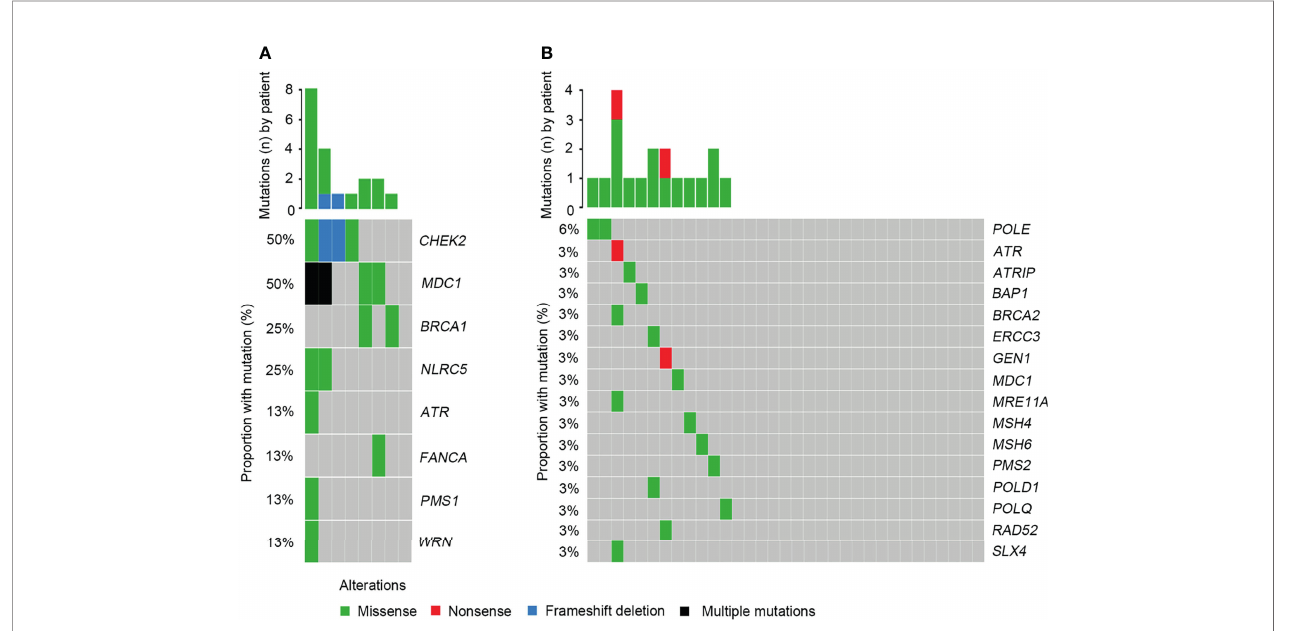
FIGURE 7 | Comparison of the DDR pro fi les between SCRC and NSCRC patients. (A) The DDR pro fi le in the SCRC group. (B) The DDR pro fi le in the NSCRC group.